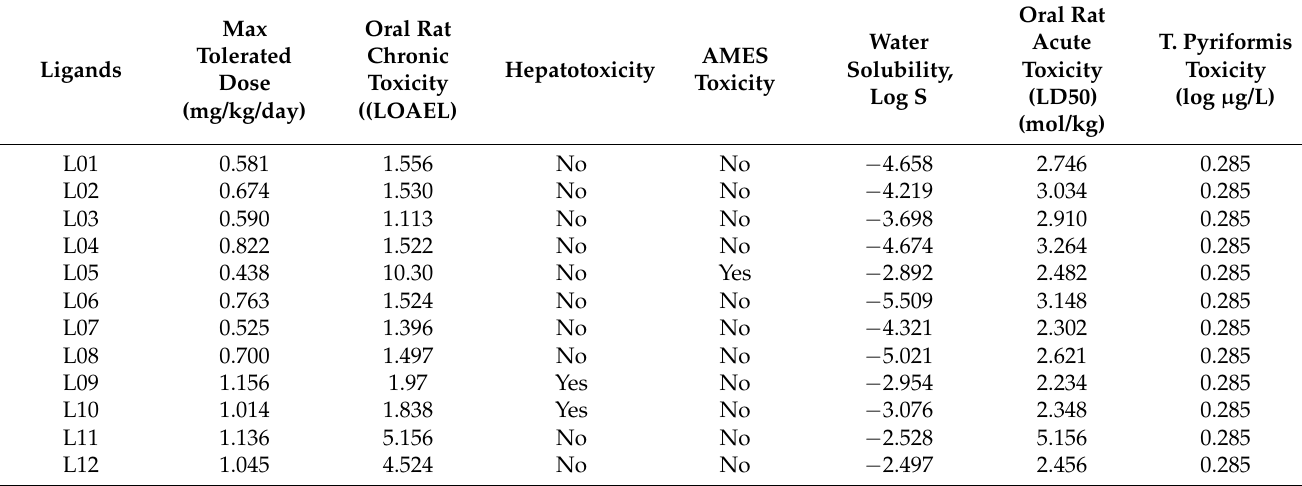
Table 8. Aquatic and non-aquatic